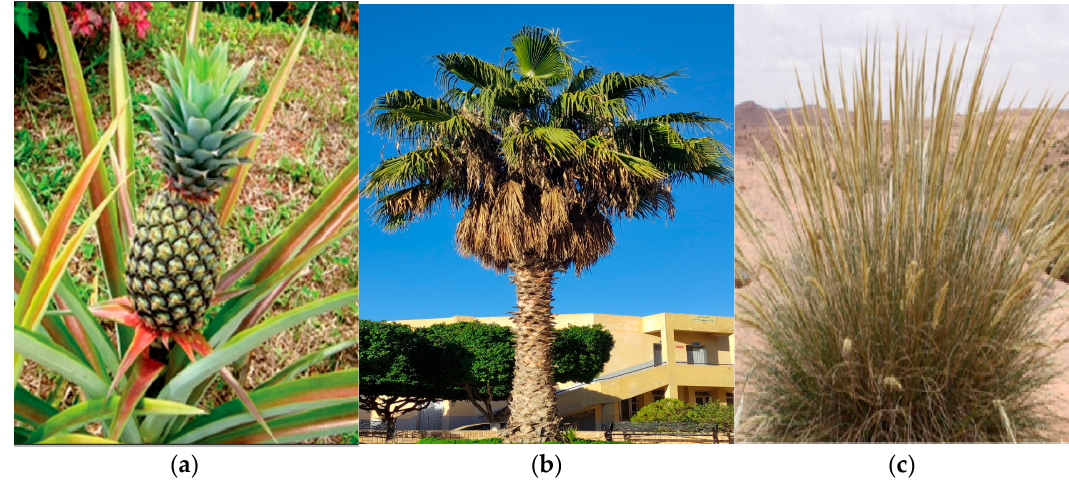
Figure 1. Natural fiber plants: ( a ) Pineapple [40], ( b ) Palm and ( c ) Alfa [12].